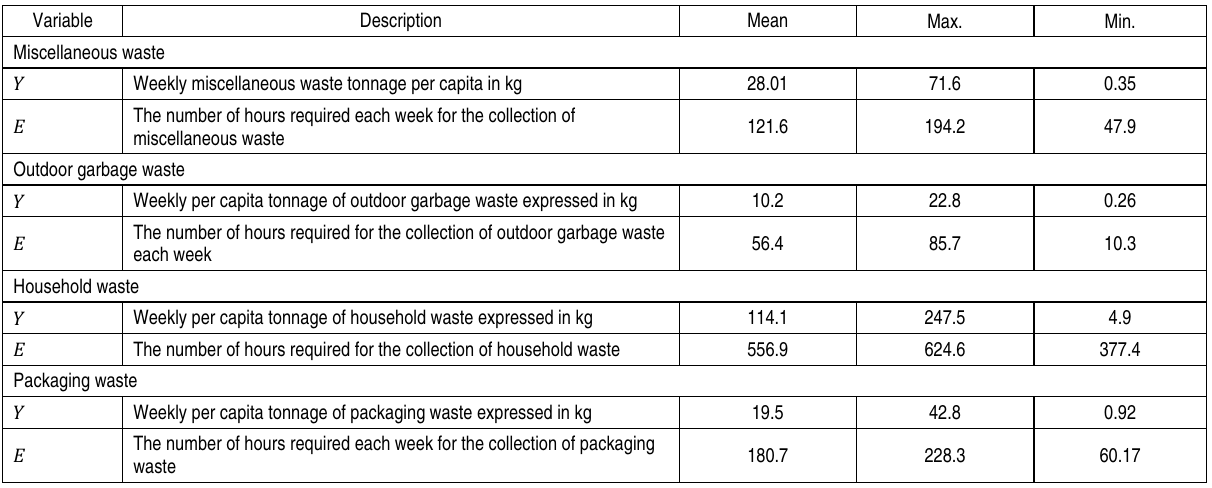
Table 1. Description of the variables and basic descriptive